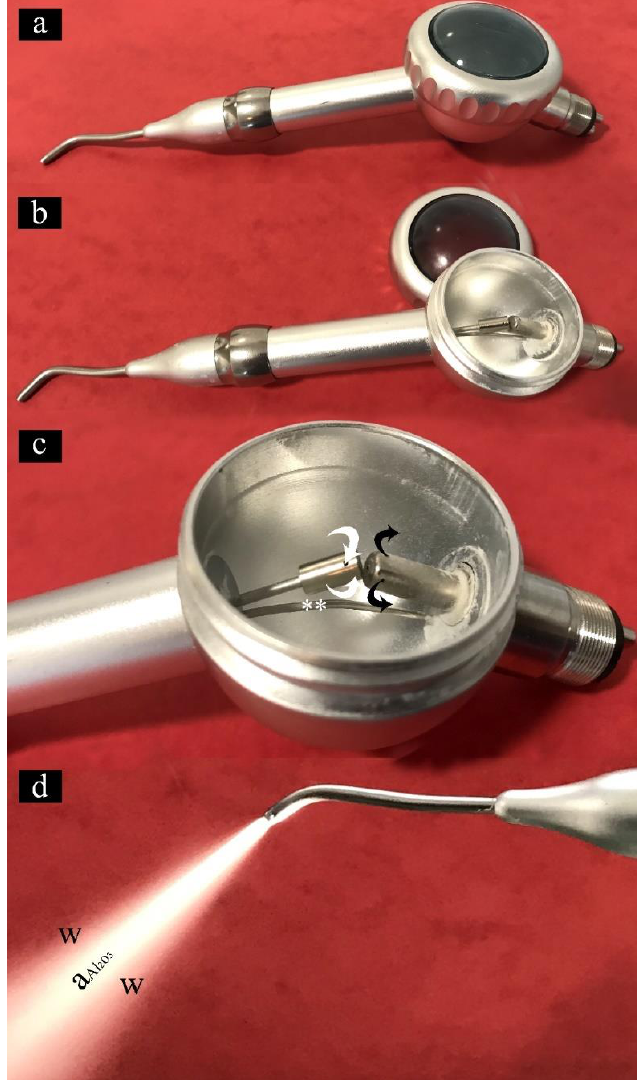
Figure 2. Images showing the main features of the prophy jet handpiece for the WAPA procedure: ( a ) external view of the prophy jet handpiece; ( b ) Al 2 O 3 particle chamber opened; ( c ) functioning of the Al 2 O 3 particle chamber. The black arrows show the flux of the incoming air; white arrows indicate the outgoing air enriched with Al 2 O 3 particles. Water is carried with a tube (**) directly to the tip of the spout; ( d ) prophy jet handpiece in operation. From the spout of the handpiece an air-jet enriched with Al 2 O 3 (aAl 2 O 3 ) reaching approximately 400 km/h is wrapped in a stream of water (W).